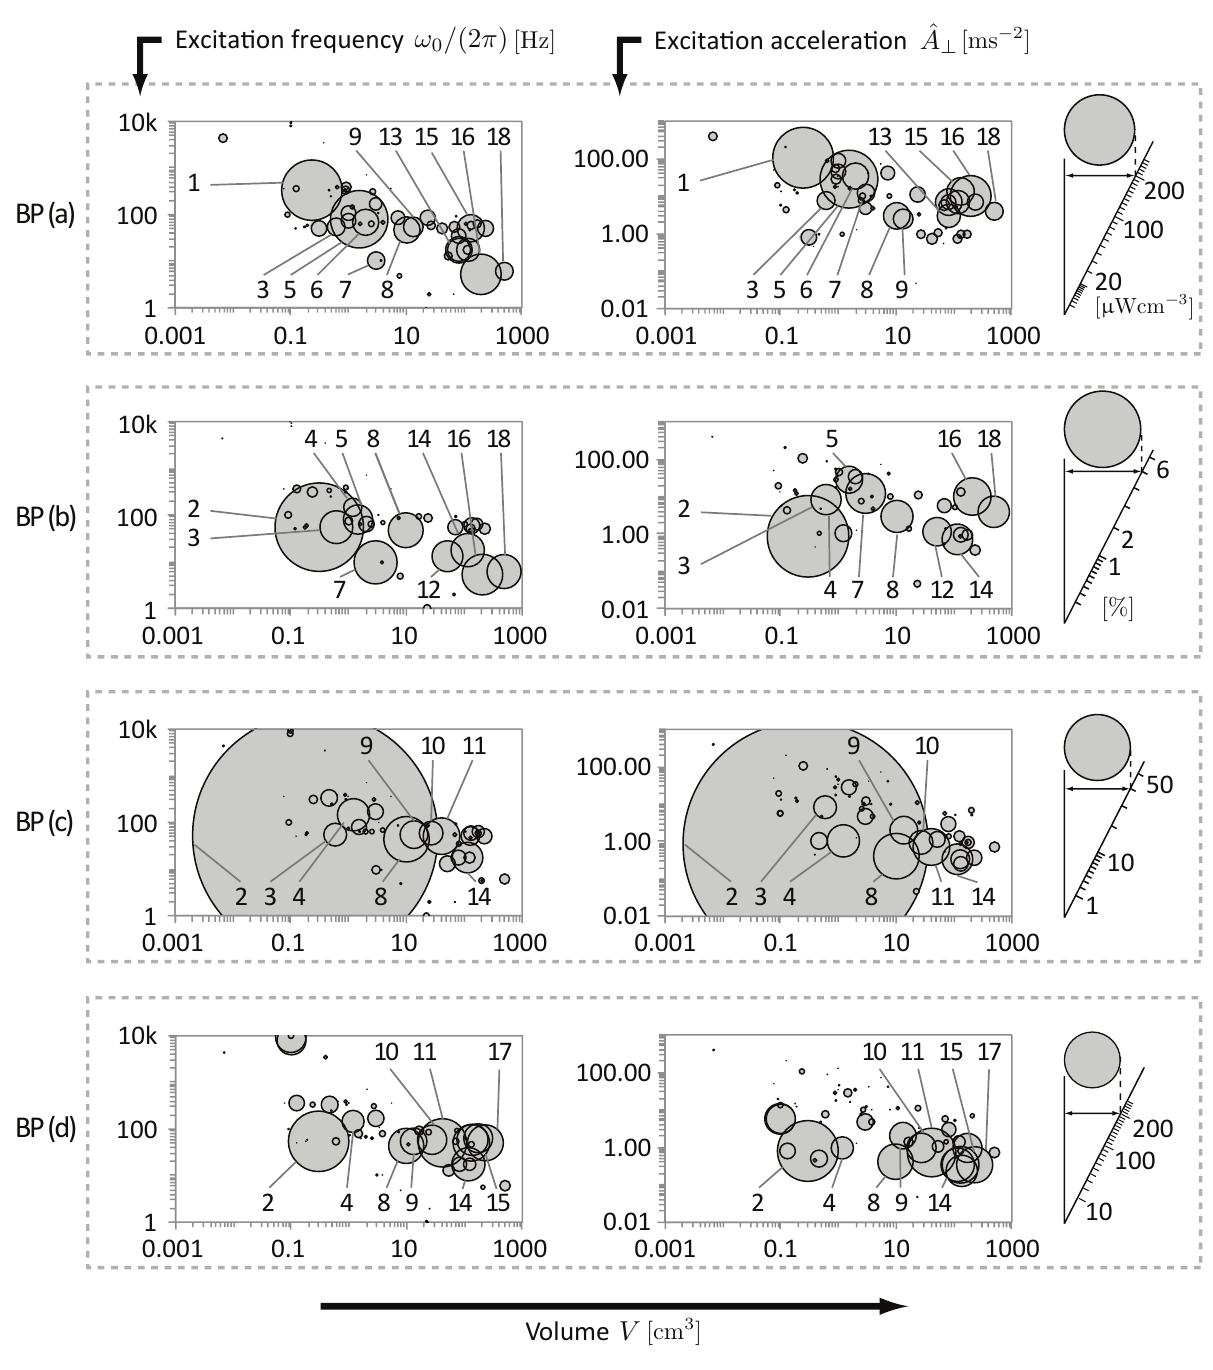
Figure 3. Benchmark plots for electrodynamic harvesters. Plots show the maximum performance of each harvester according to the respective BP as well as available measurement data and with respect to the corresponding acceleration and frequency. Values are proportional to the area of circle and according to Table